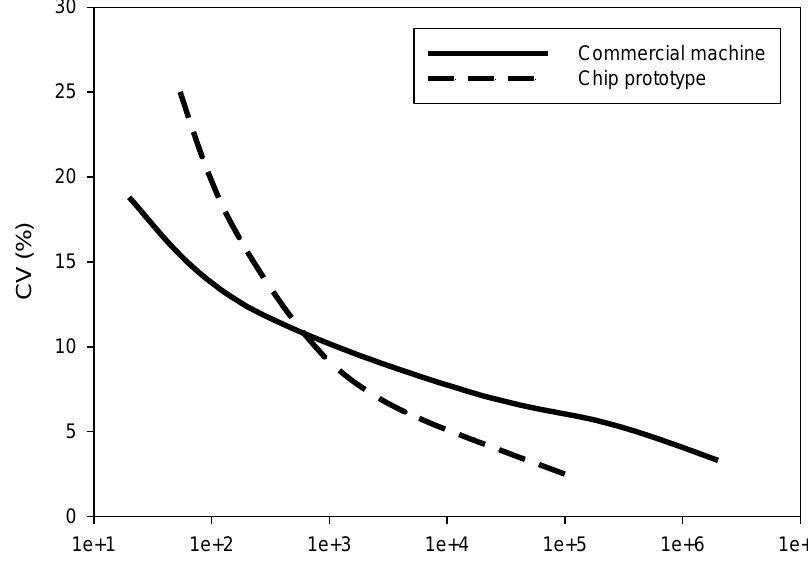
Figure 11. Index of experiment reproducibility by the coefficient of variant, CV (%). DNA quantification experiments using the commercial machine and the chip are compared with samples of initial DNA copy numbers from 10 to 10 6 . The results show that DNA quantification by a chip has high reproducibility for samples with high concentration levels from 10 5 to 10 3 copies per